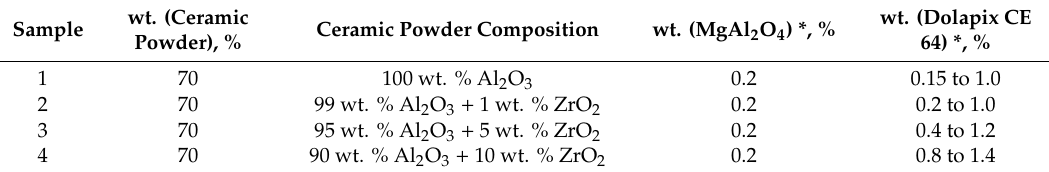
Table 3. The composition of suspensions for determining the optimal amount of dispersant DOLAPIX CE 64.